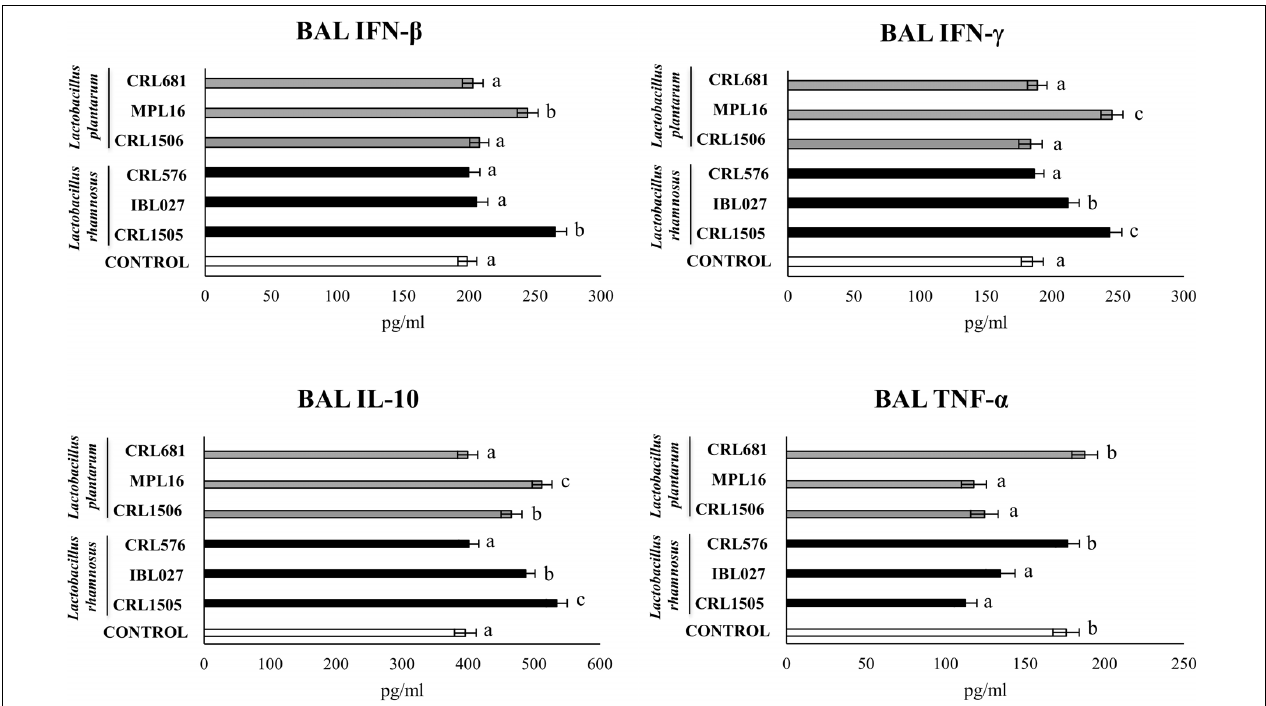
FIGURE 8 | Levels of bronchoalveolar lavage (BAL) interferons (IFN- β and IFN- γ ), TNF- α , and interleukin 10 (IL-10) in mice orally treated with Lactobacillus rhamnosus CRL1505, L. rhamnosus IBL027, L. rhamnosus CRL576, Lactobacillus plantarum CRL1506, L. plantarum MPL16, or L. plantarum CRL681 (10 8 cells/mouse per day for 5 consecutive days) and then challenged by the nasal route with 250 µ g of the viral molecular–associated pattern poly(I:C) for three consecutive days. Mice with no lactobacilli treatment and challenged with poly(I:C) were used as controls. Bronchoalveolar lavage immune factors were evaluated on day 2 after the last poly(:C) administration. The results represent data from three independent experiments ( n = 6 per group). Letters indicate significant differences ( P < 0.05), a < b <